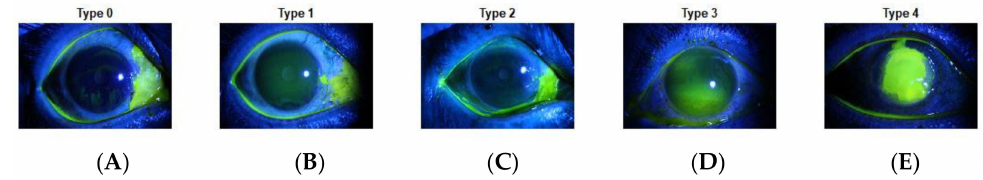
Figure 4. ( A ) Type 0, ( B ) Type 1, ( C ) Type 2, ( D ) Type 4, and ( E ) Type